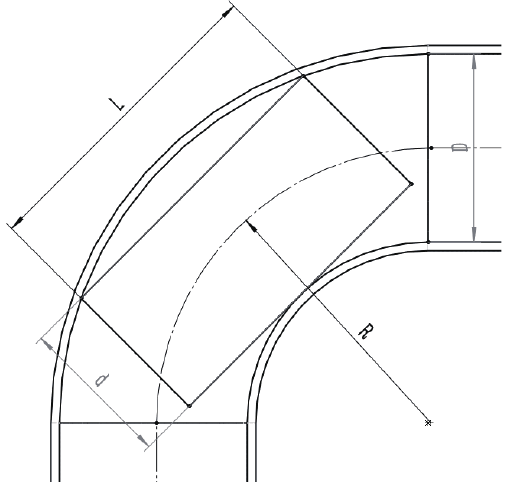
Figure 6. Geometric constraints schematic of the robot in bend.